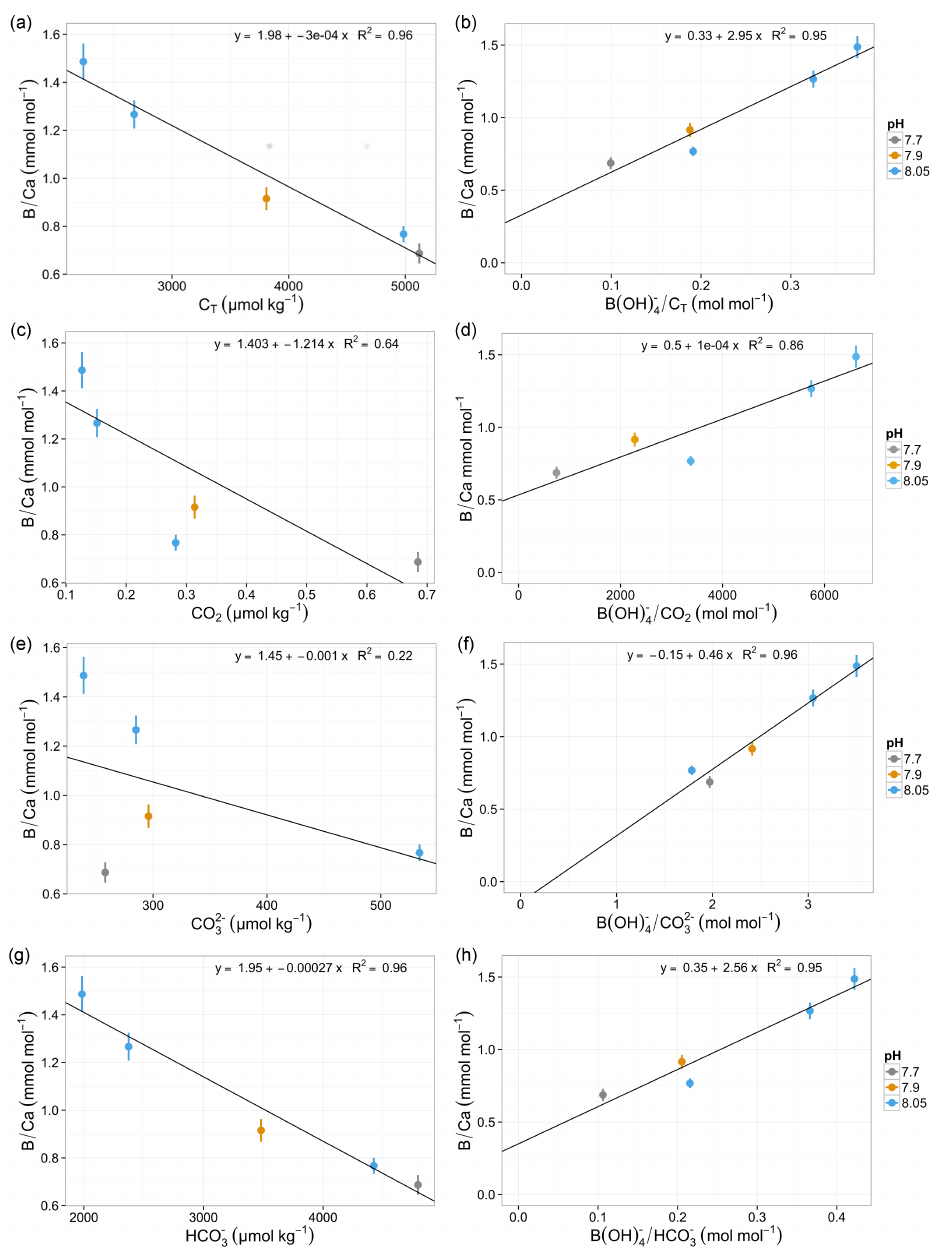
Figure 2. B / Ca ratios plotted against (a) [ C T ], (b) [B(OH) − ] / [ C T ] ratio, (c) [CO 2 ], (d) [B(OH) − 4 (f) [B(OH) − ] / [CO 2 − ], (g) [HCO − ], (h) [B(OH) − ] / [HCO − ], error bars represent standard error. 4 3 3 4 3